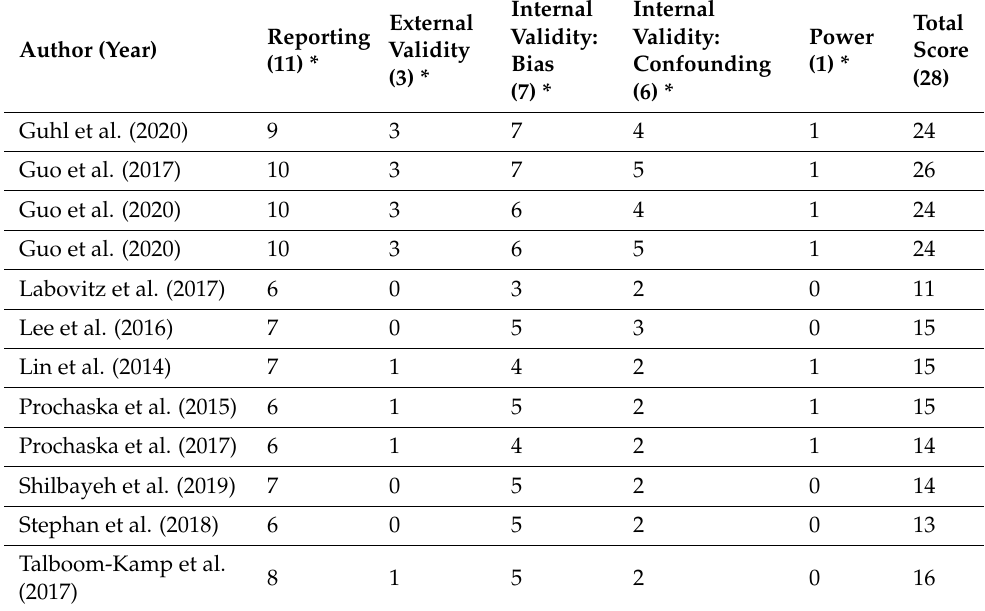
Table 3. Quality